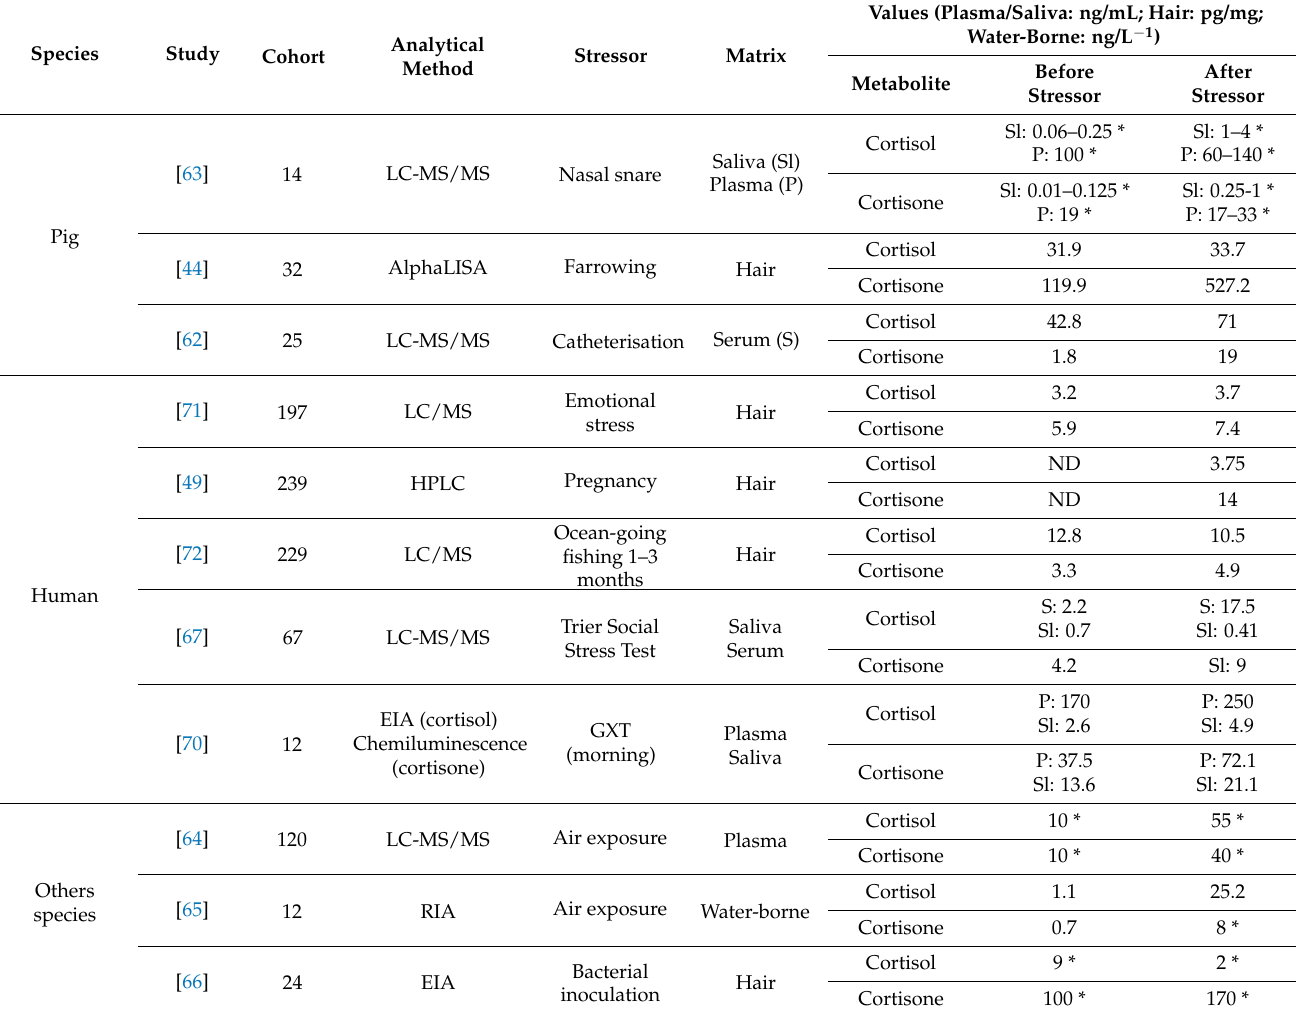
Table 3. Examples where cortisol and cortisone were measured in combination after a